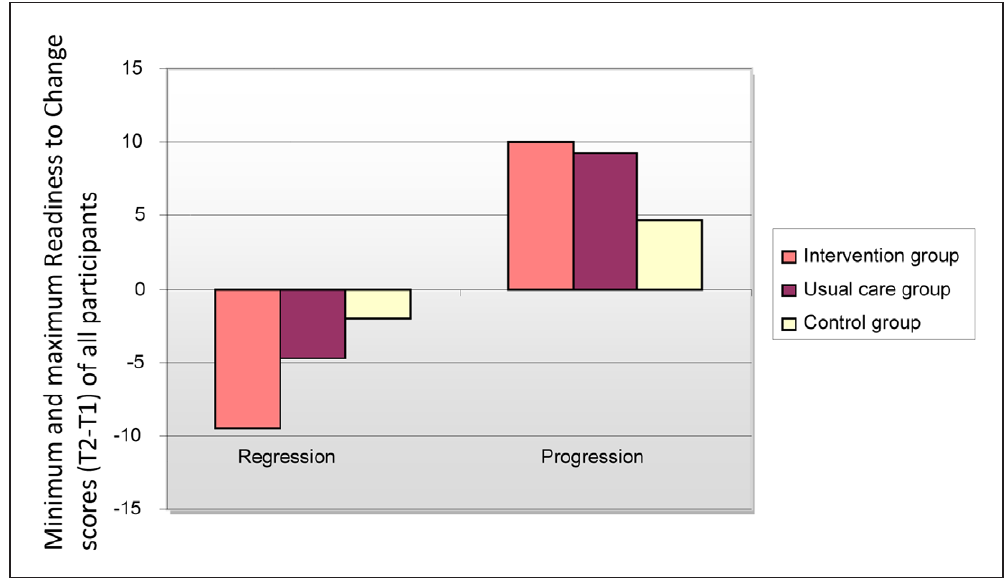
Figure 1: Graph indicating the range in degree of positive change (progression) and negative change (regression) in Readiness to Change scores between T1 and T2 by group across all